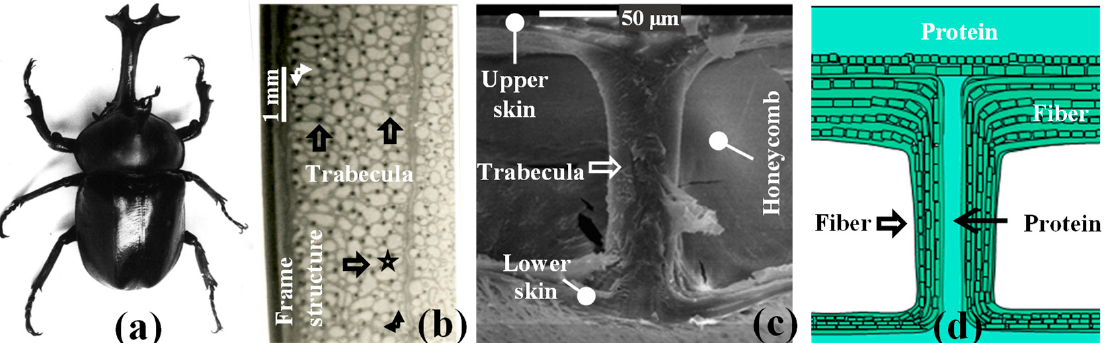
Figure 1. The origin of the BEP. ( a ) An adult A. dichotoma beetle; ( b ) microstructure of an A. dichotoma forewing; ( c ) trabeculae in the forewing; and ( d ) a simple model of a trabecular structure (Adapted from reference [32] with permission).